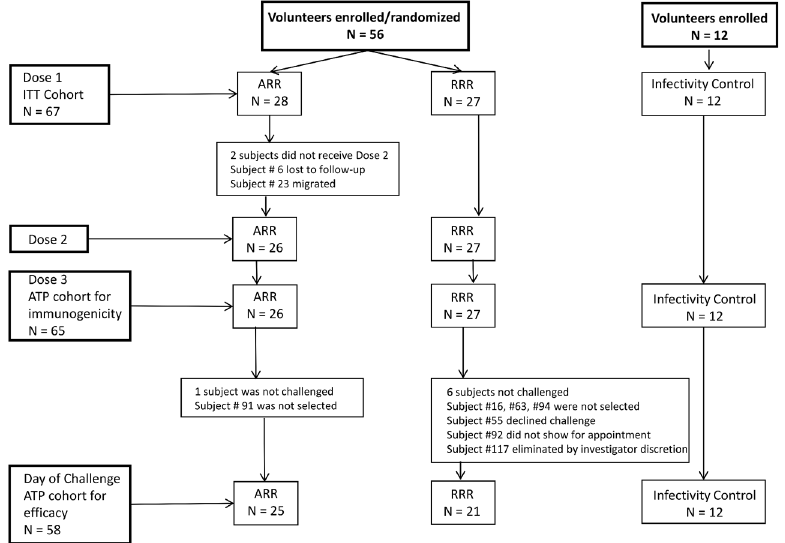
Fig 1. Flow diagram. The number of subjects completing each immunization and controlled human malaria infection. ARR = first dose with Ad35.CS, second and third doses with RTS,S/AS01 B . RRR = three doses of RTS,S/AS01